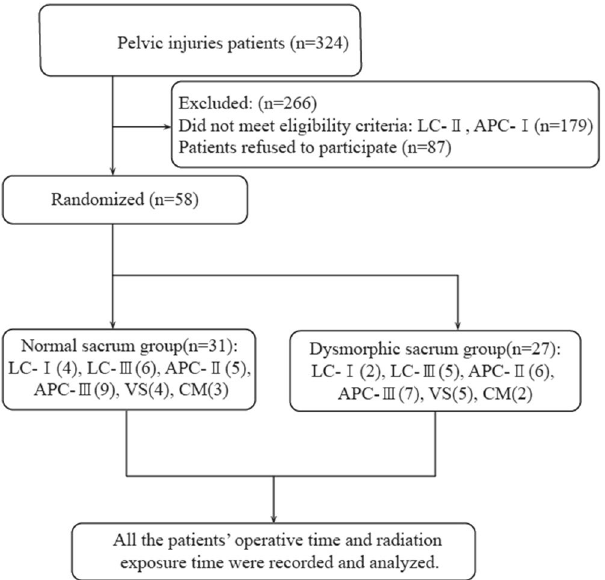
Figure 1. Recruitment of patients with pelvic injuries and data collection